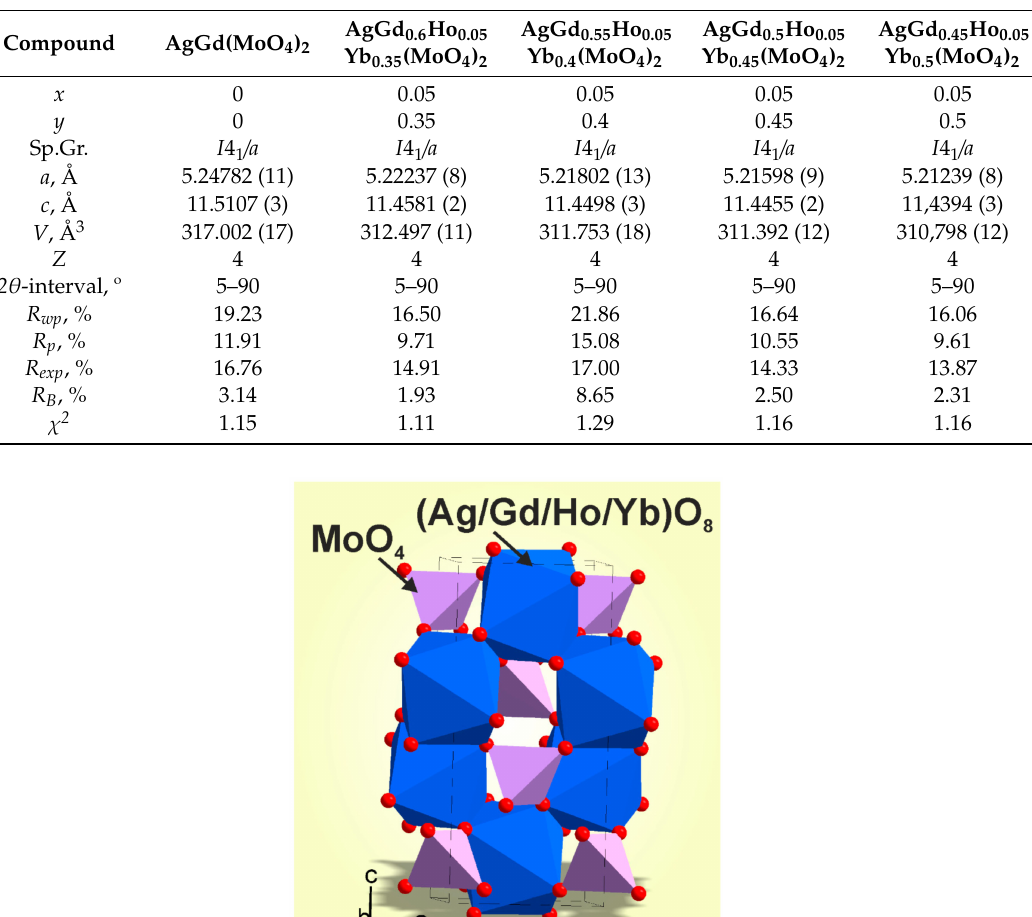
Table 1. Main parameters of processing and refinement of the AgGd 1 − x − y Ho x Yb y (MoO 4 ) 2 samples.